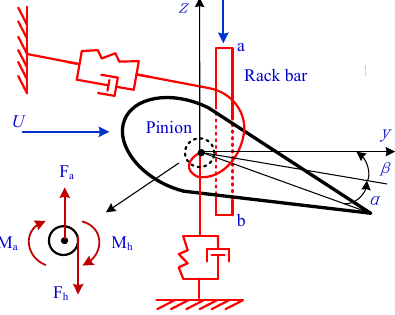
Figure 1. The coordinate system and the 3-DOF blade section.